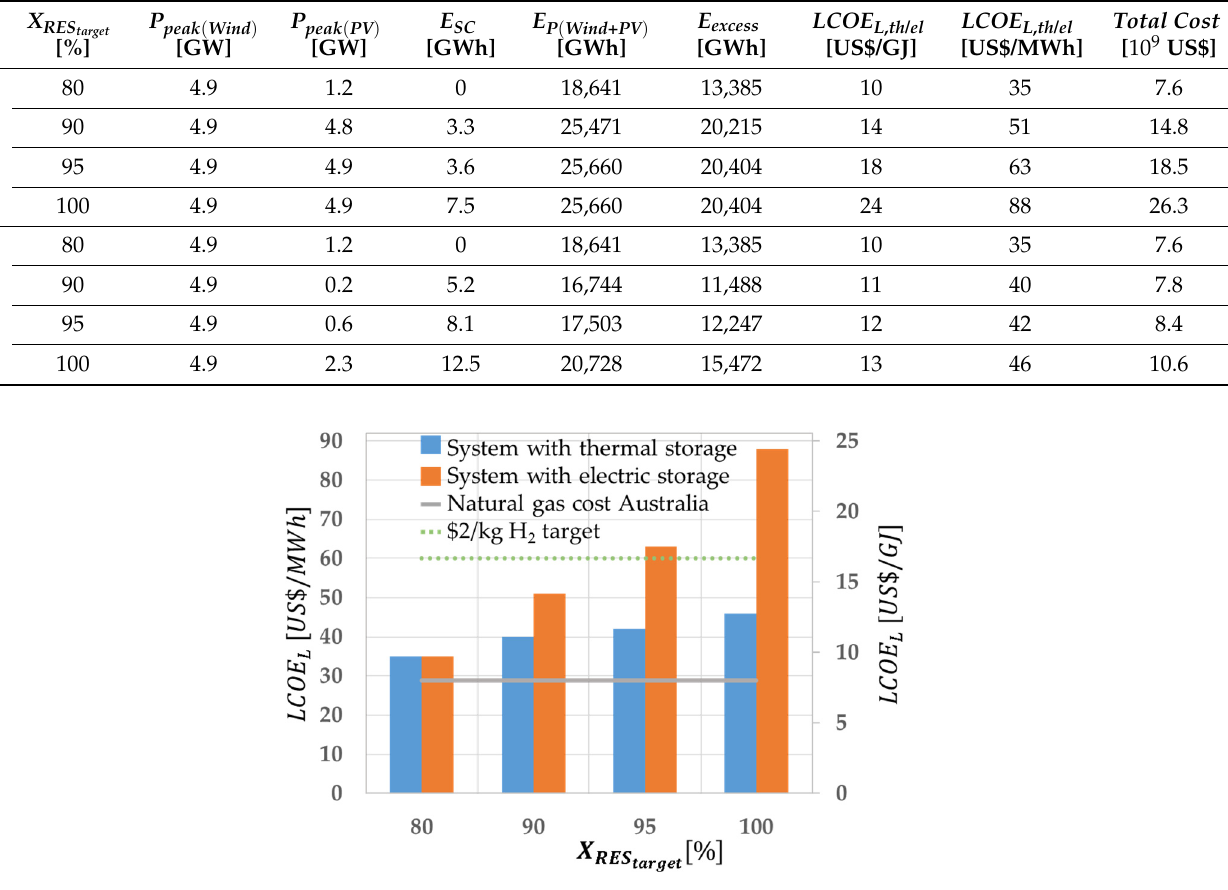
Table 10. Summary of the minimum LCOE values calculated for all configurations. The ratio be- tween the two scenarios is further shown.